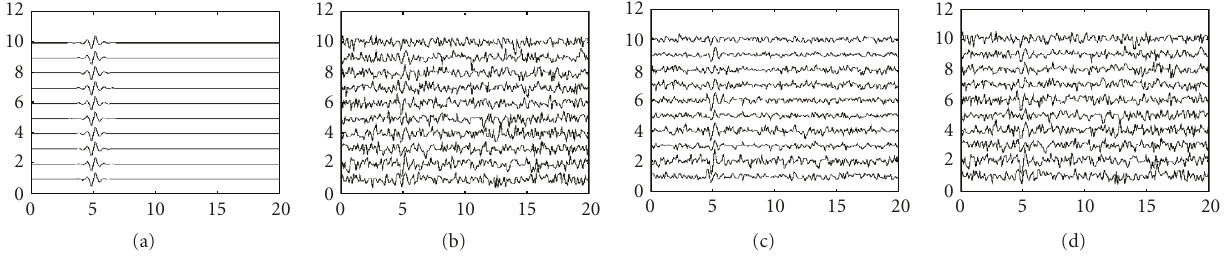
Figure 2: Polarization component 1 of a seismic signal: nonnoisy impaired results with LRTA-(8,8,3), and result with MWF-(8,8,3).